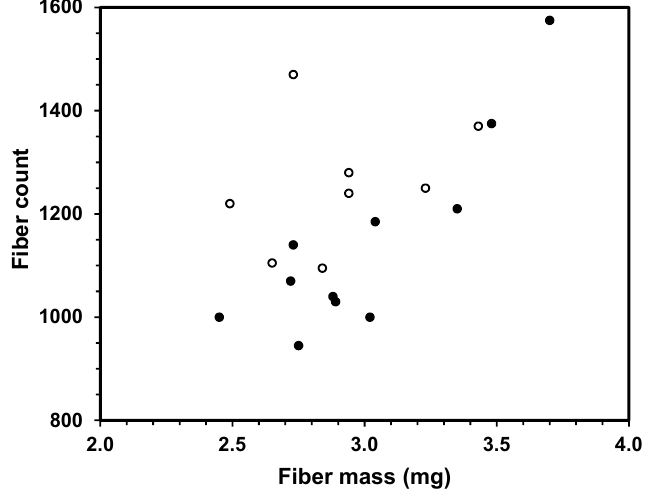
Figure 6. Representation of Figure 3b with two subsets of fine ( ○ ) and coarse ( ● )